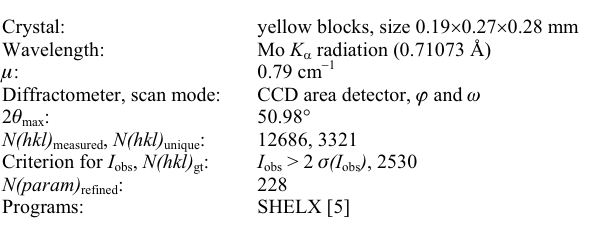
Table 1. Data collection and handling.